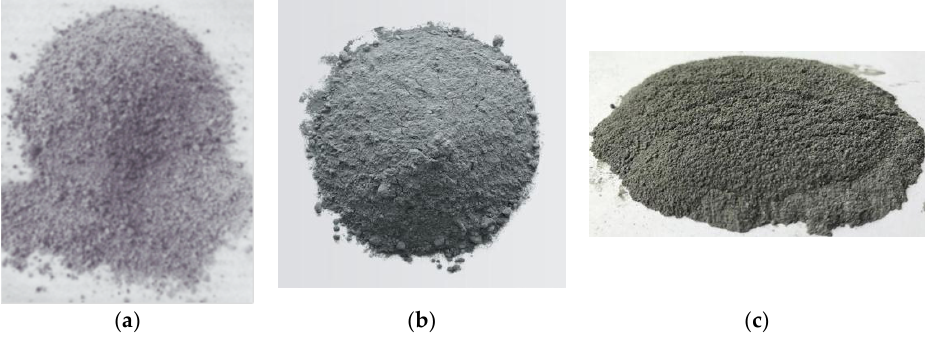
Figure 1. ( a ) Blast furnace slag, ( b ) fly ash and ( c ) microsilica from Elkem utilized for the tests. Table 1. Properties and chemical composition of the materials utilized in the concrete mix.